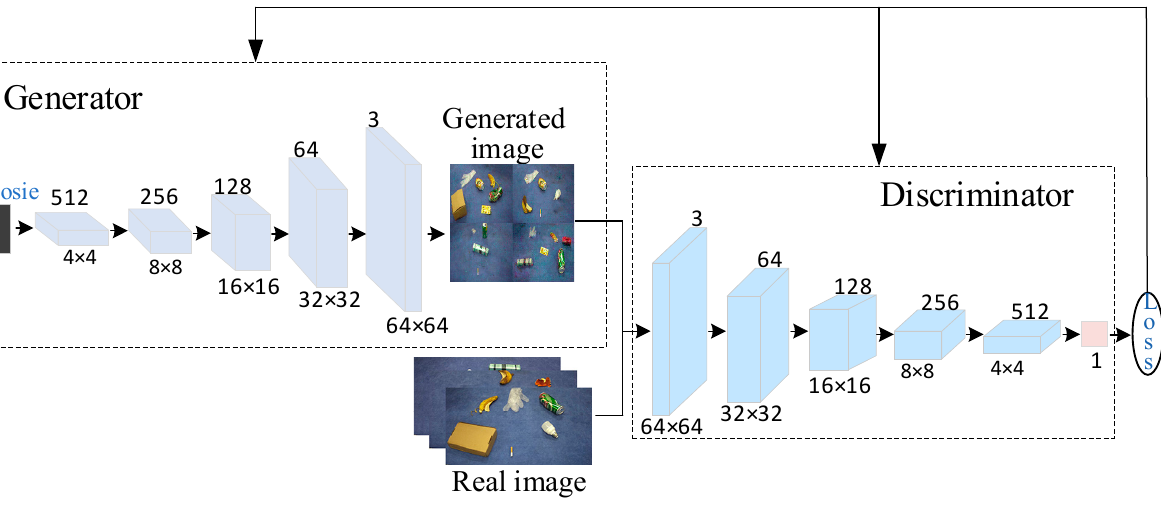
Figure 2. DCGAN network